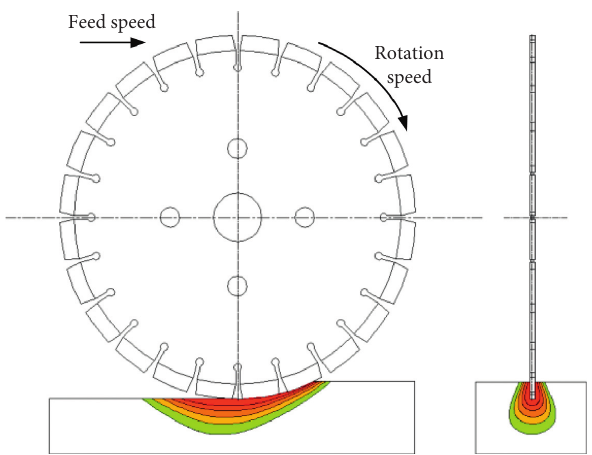
Figure 11: Stress distribution diagram of rock cutting with the diamond sawblade.